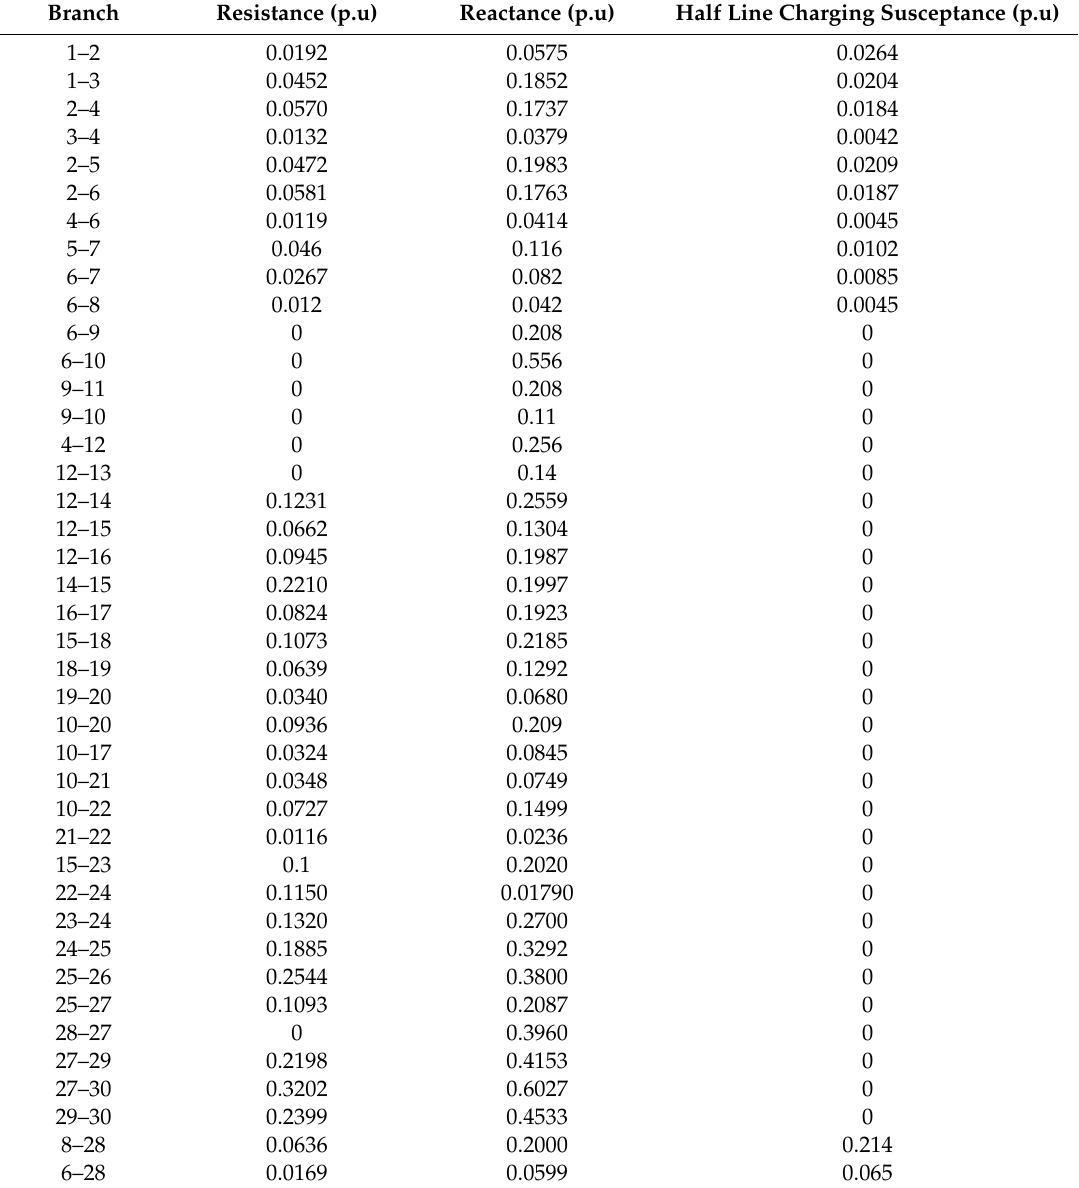
Table A2. Branch profile of the modified IEEE 30 bus